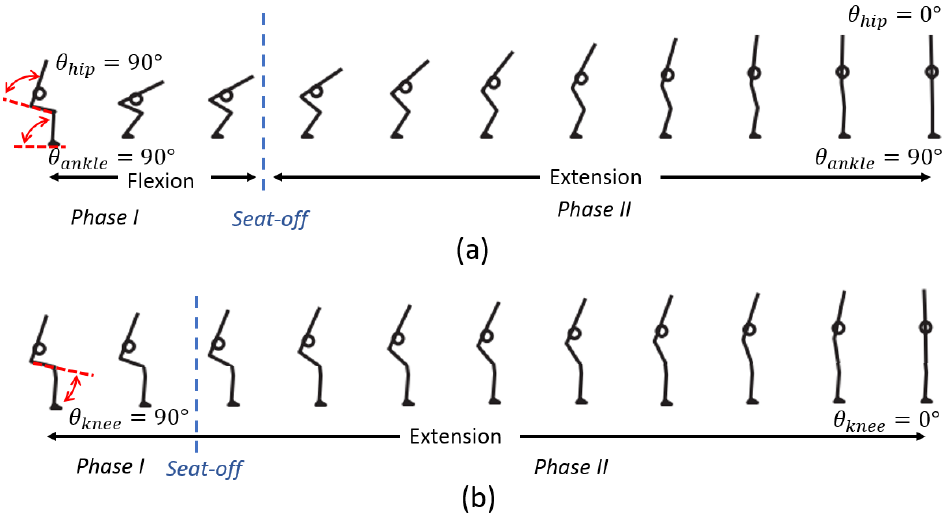
Figure 1. Body configuration in sit-to-stand (STS) movement ( a ) bending of the trunk followed by extending of the lower limbs by correct STS transfer skill ( b ) extending of the lower limbs without bending of the trunk by incorrect STS transfer